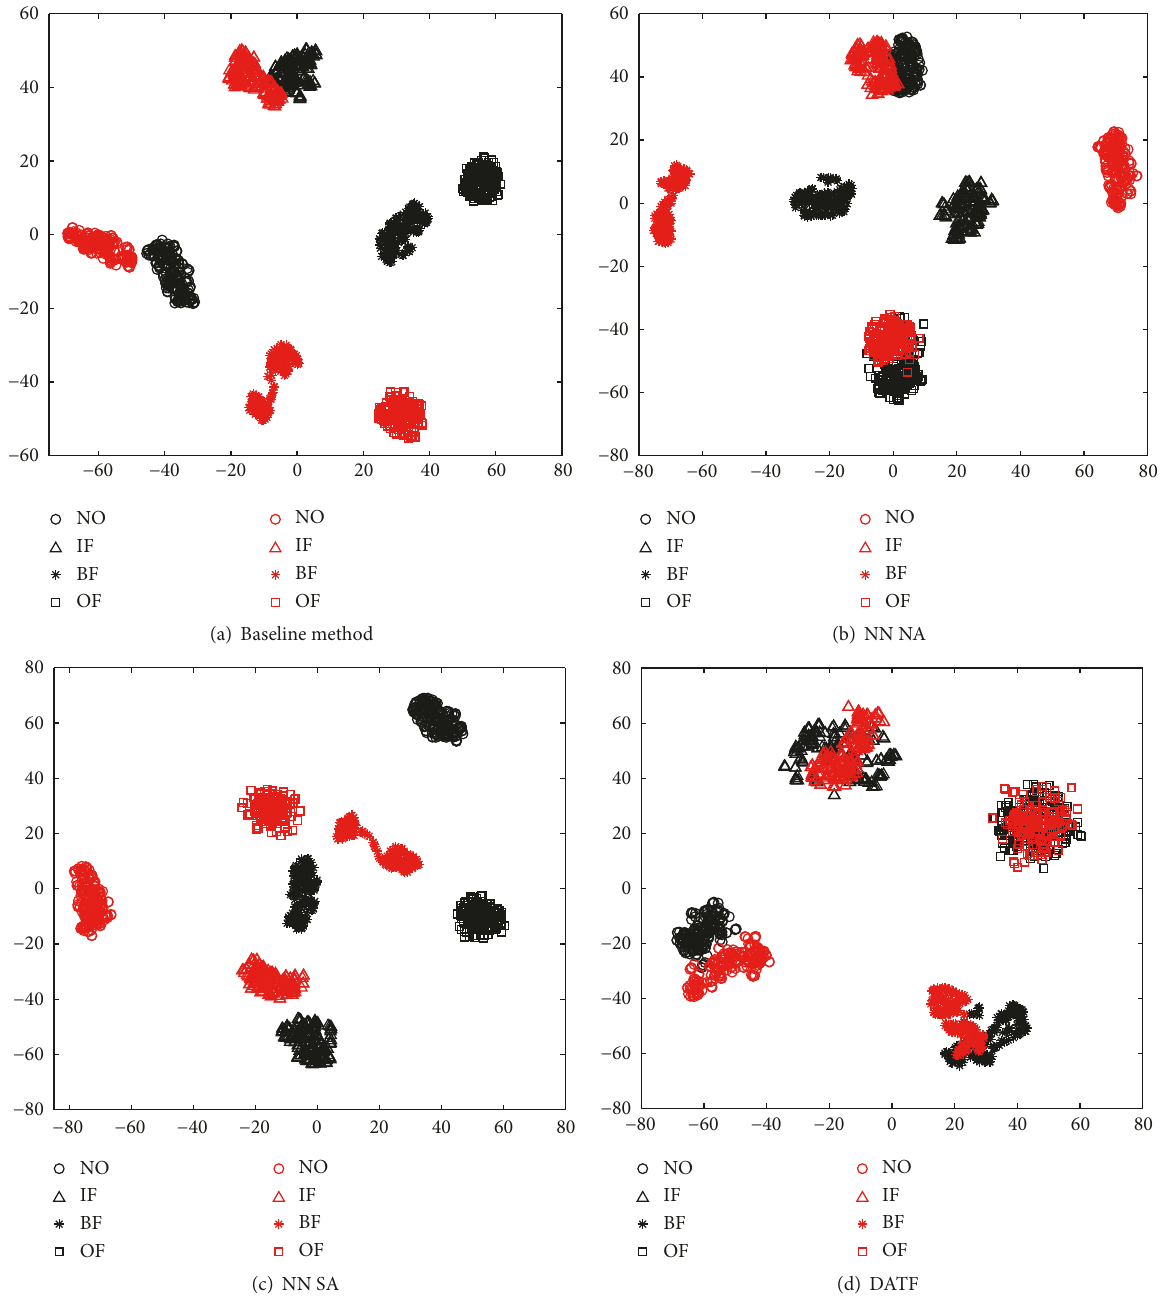
Figure 10: Feature visualization via t-SNE [31] over a fault diagnosis task from training domain L1 (blue) to test domain L2 (red) under different working